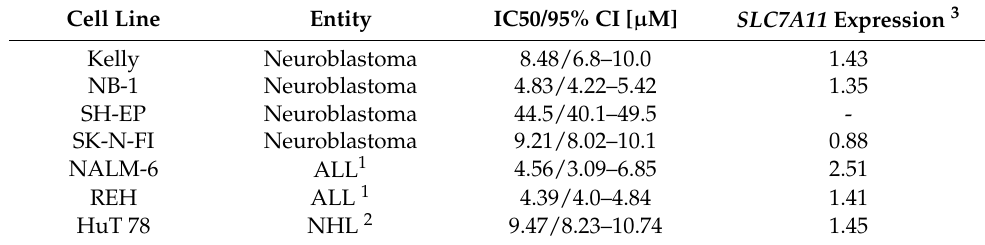
HCC: Liver cancer, HGG: high-grade glioma, HNC: Head and Neck Cancer, KID: Kidney Cancer, LYM: Lymphoma, MED: medulloblastoma, MRT: malignant rhabdoid tumor, NB: neuroblastoma, ND: not defined, NHL: non-Hodgkin lymphoma, EWS: Ewing sarcoma, OST: osteosarcoma, RBD: Rhabdoid, RMS: rhabdomyosarcoma, OTHS: other sarcoma, WILMS: nephroblastoma, OTH: other, OTHB: other brain tumor. * p < 0.05, ** p < 0.01, *** p < 0.001. Table 3. Sensitivity to APR-246 in seven different